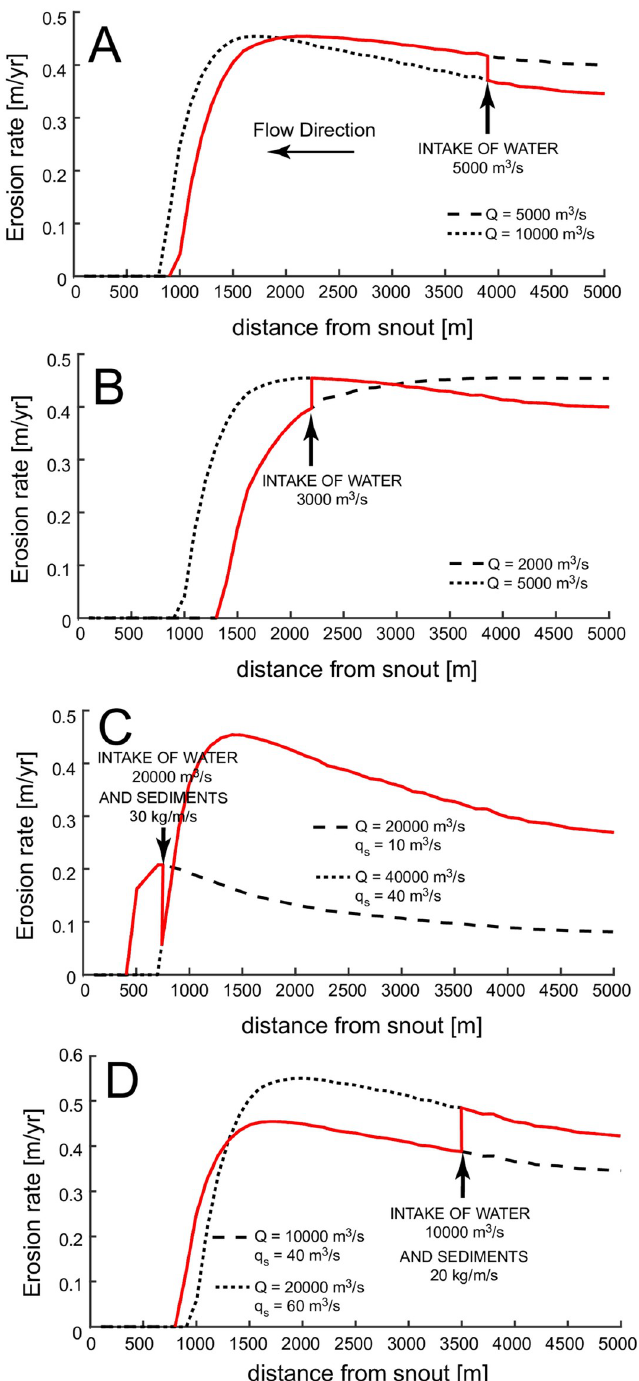
Fig 9. Distribution of erosion rates in a subglacial channel before and after a confluence with another channel. The dashed line is the erosion rate with the initial discharge and sediment load of the main channel, the black arrow is the location where the secondary channel discharges water and sediments, dotted line is the erosion rate with the final sediment discharge and sediment load (sum of the contribution of the two channels), the red line is the distribution of erosion rate before and after the confluence. In A) and B) the secondary channel is adding only water in the main channel while in C) and D) it is also adding sediment load. In A) and C) the erosion rate is higher after the confluence while in B) and D) it is